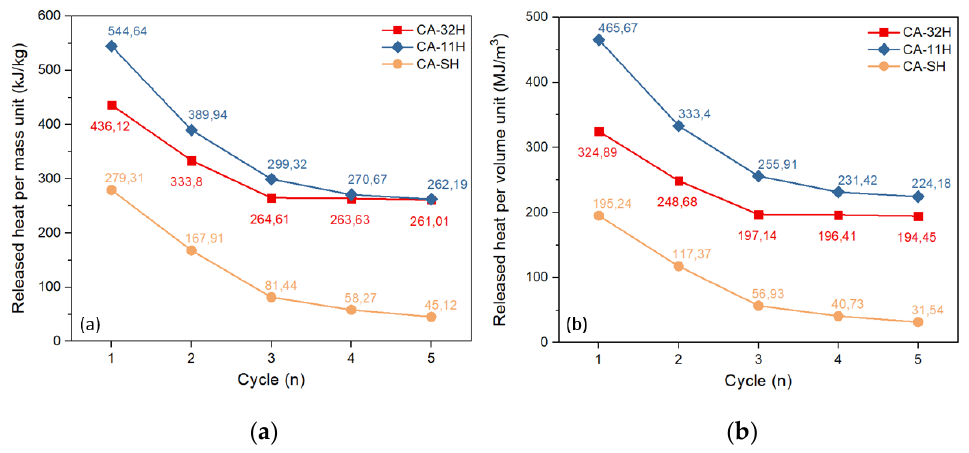
Figure 10. Released heat per mass unit ( a ) and volume unit ( b ) per cycle.